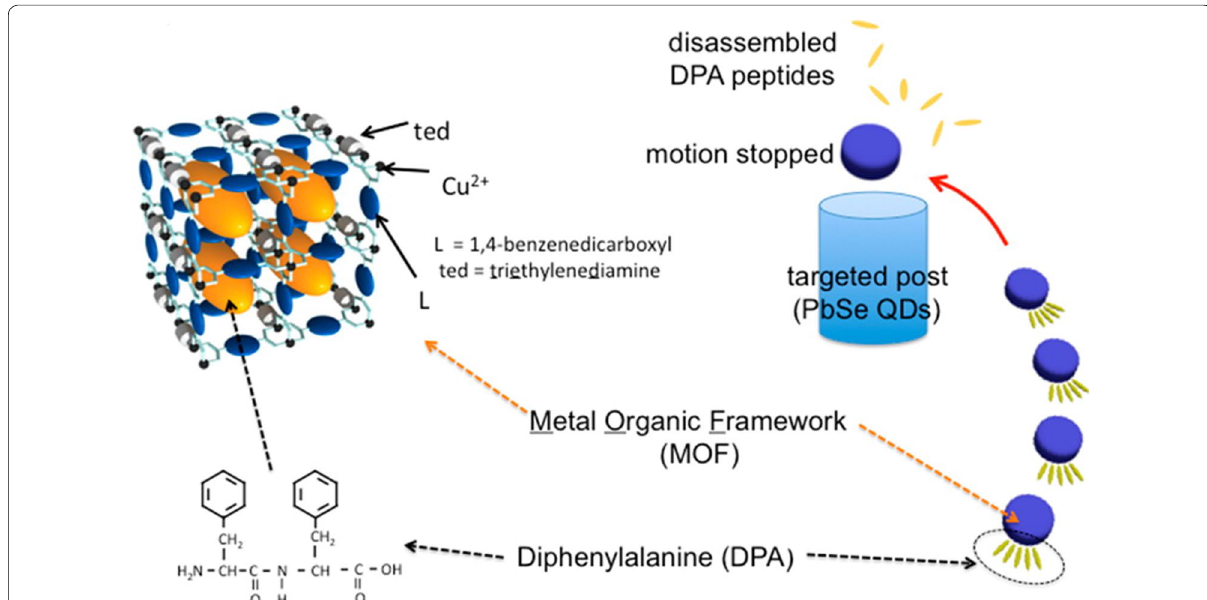
Fig. 9 Scheme depicting peptide-MOF motor swimming toward high pH. The reassembly of released hydrophobic DPA peptides on the edges of the framework produces an asymmetric surface tension distribution that powers motion towards the higher surface tension side (left). A change of pH gradient in environment prompts completion of the motion due to higher pH conditions disassembling DPA peptides on the MOF (right) (Reprinted (adapted) with permission from Ref. [98]. Copyright 2015 American Chemical